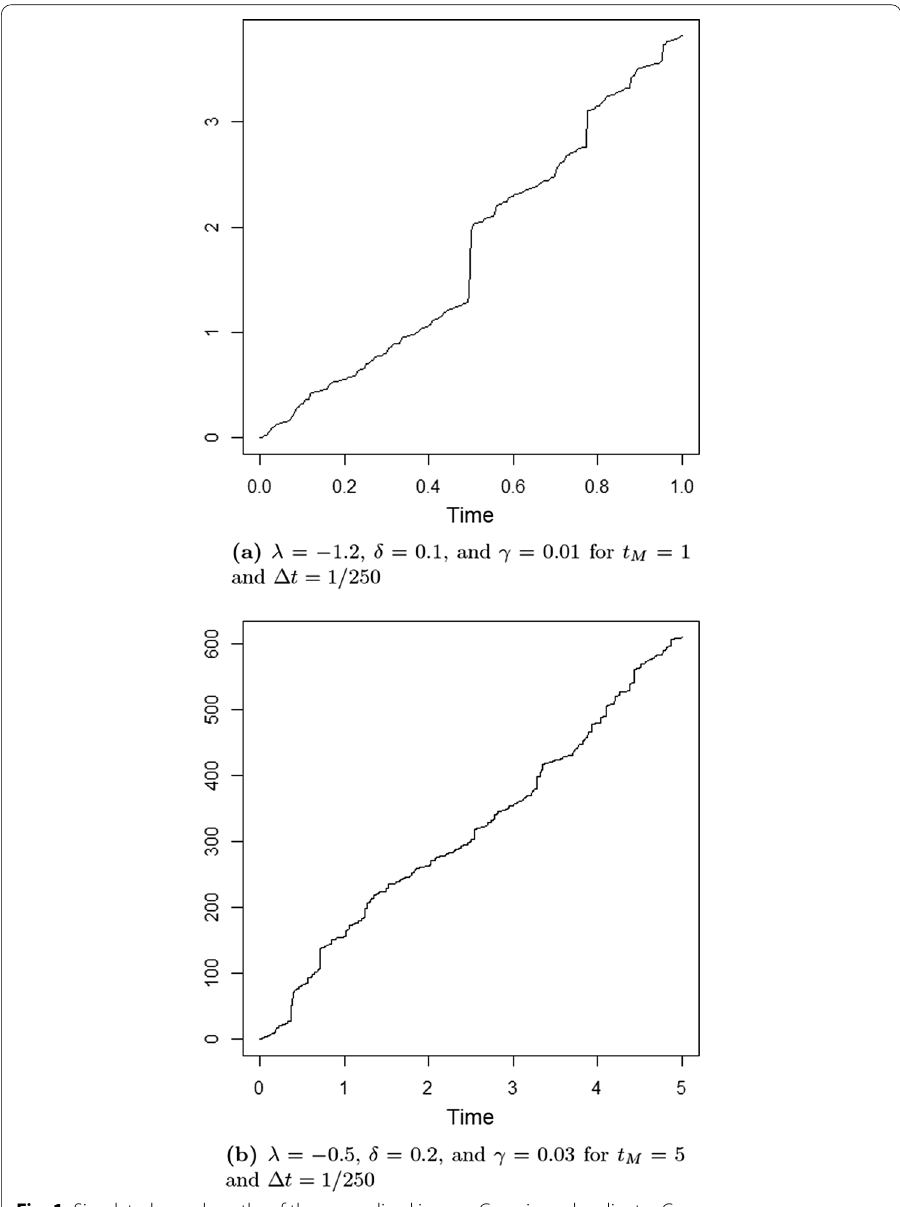
Fig. 1 Simulated sample paths of the generalized inverse Gaussian subordinator